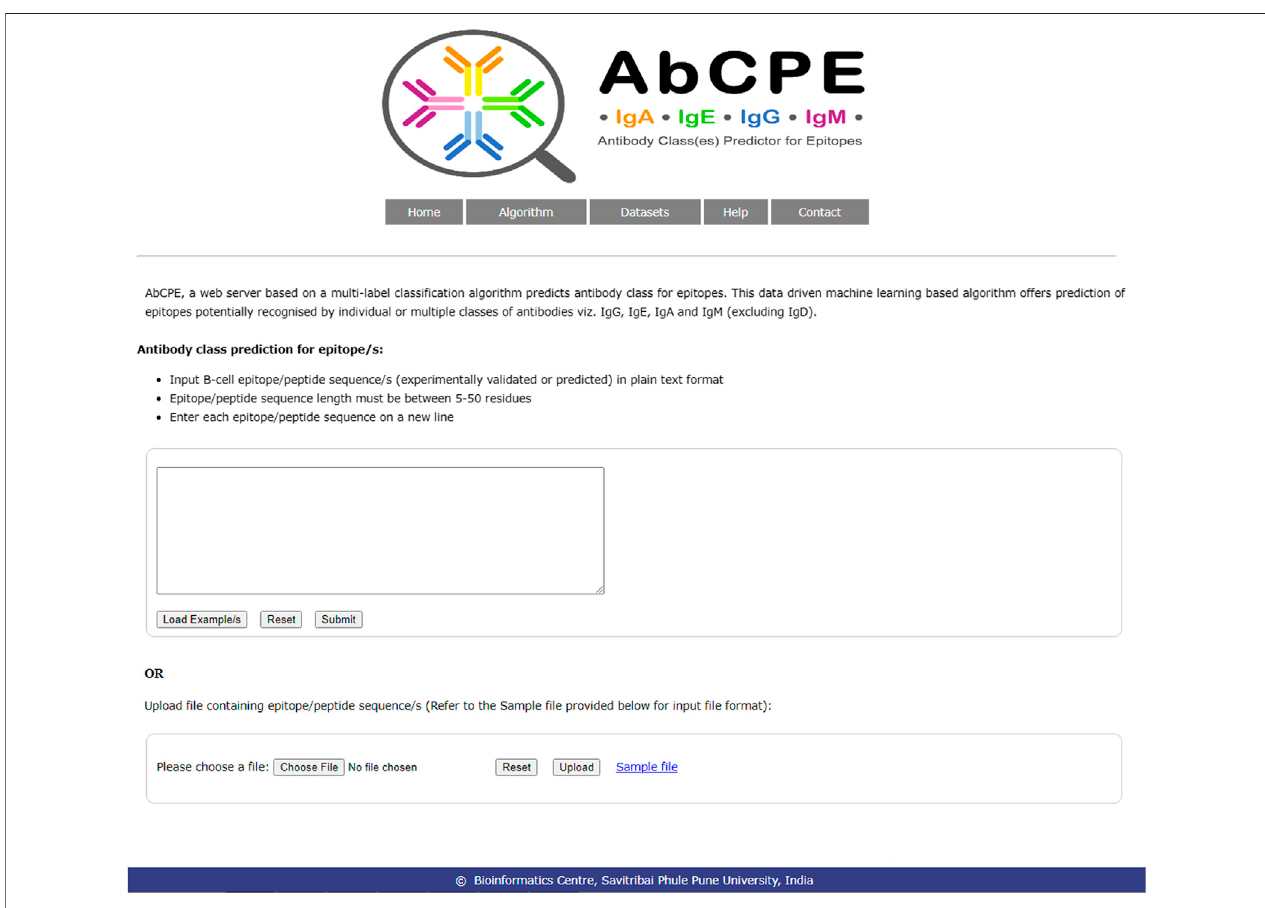
FIGURE 3 | Snapshot of AbCPE home